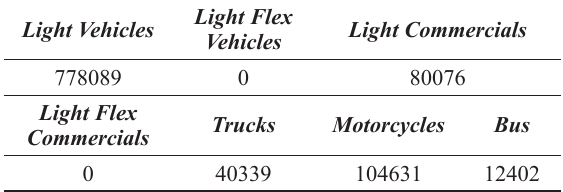
Vehicle fleet by category in the MRPA in 2001 (by unities). The data are originated from DENATRAN,